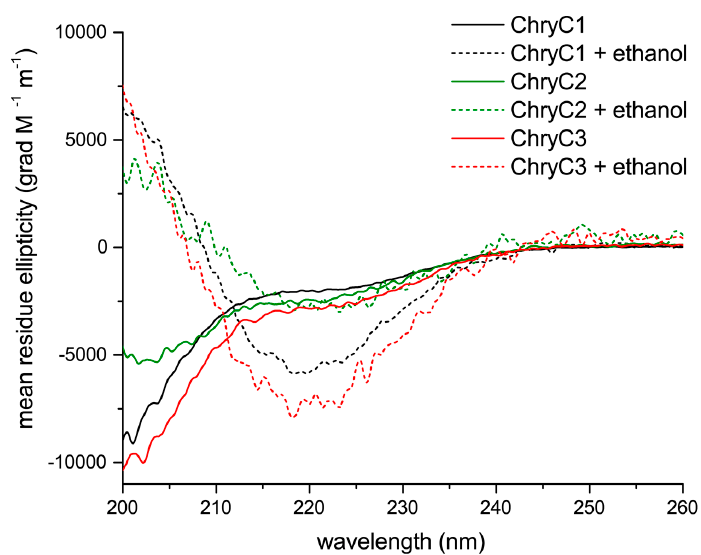
Figure 4. Circular dichroism spectra of ChryC1, ChryC2, and ChryC3 in 10 mM NH 4 HCO 3 , in the absence or presence of four volumes of 100% ethanol (pro analysis; p.a.), respectively.